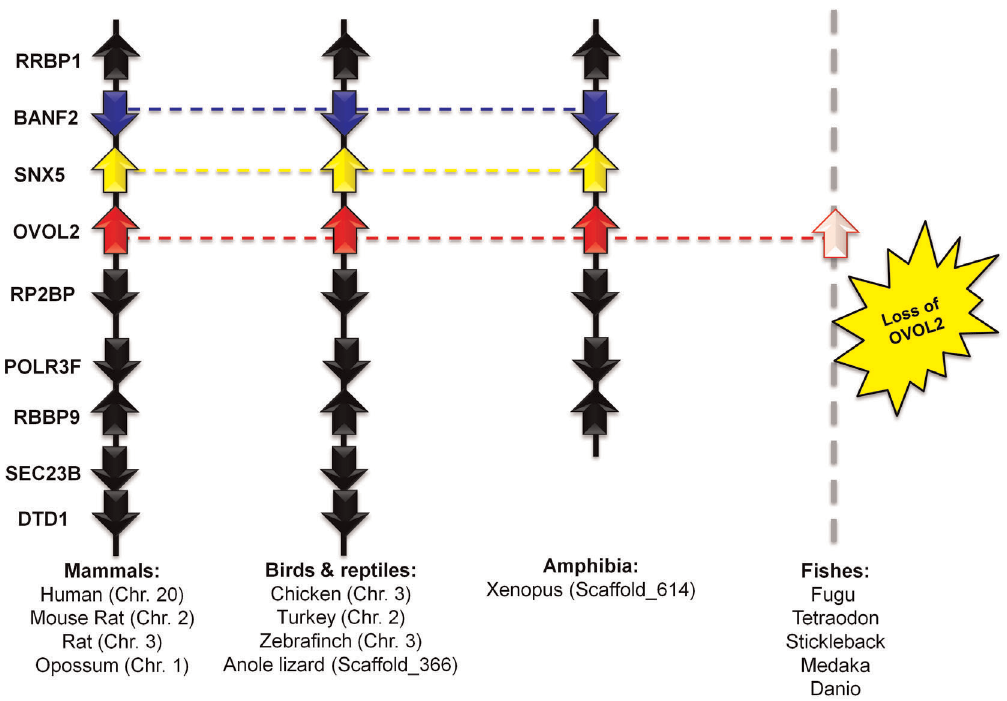
Figure 4. OVOL2 orthologs identified in vertebrates by comparing chromosomal localization. RRBP1: ribosome binding protein 1 homolog; BANF2: barrier to autointegration factor 2; SNX5: sorting nexin 5; CSRP2BP: CSRP2 binding protein; SEC23B: protein transport protein